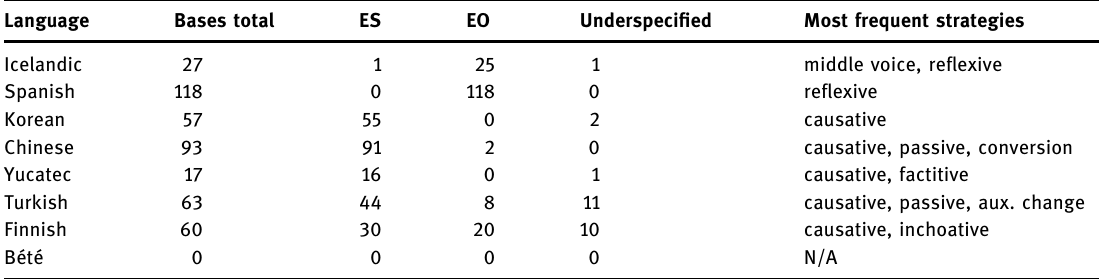
Table 2: Distribution of basic form orientation in sample